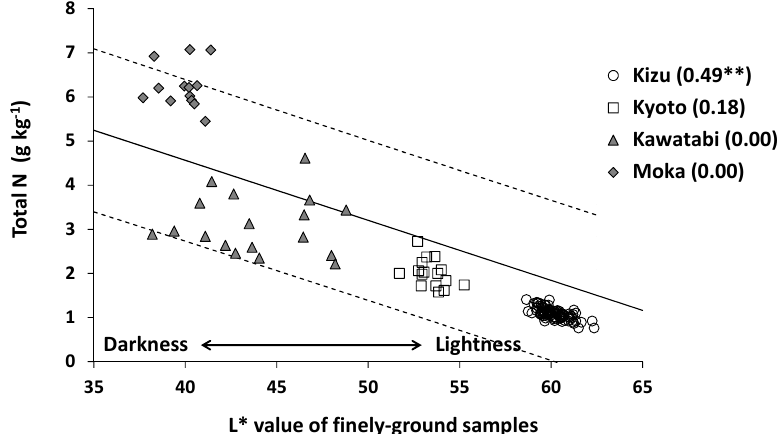
Figure 7. Relationship between the L* value of finely-ground samples and total N content at farm scale. The solid line in the figure shows the regression line obtained from the nationwide samples ( n = 147) [20], and the broken lines indicate the prediction interval at 95% confidence. ** indicates statistical significance of the determination coefficient at p < 0.01.